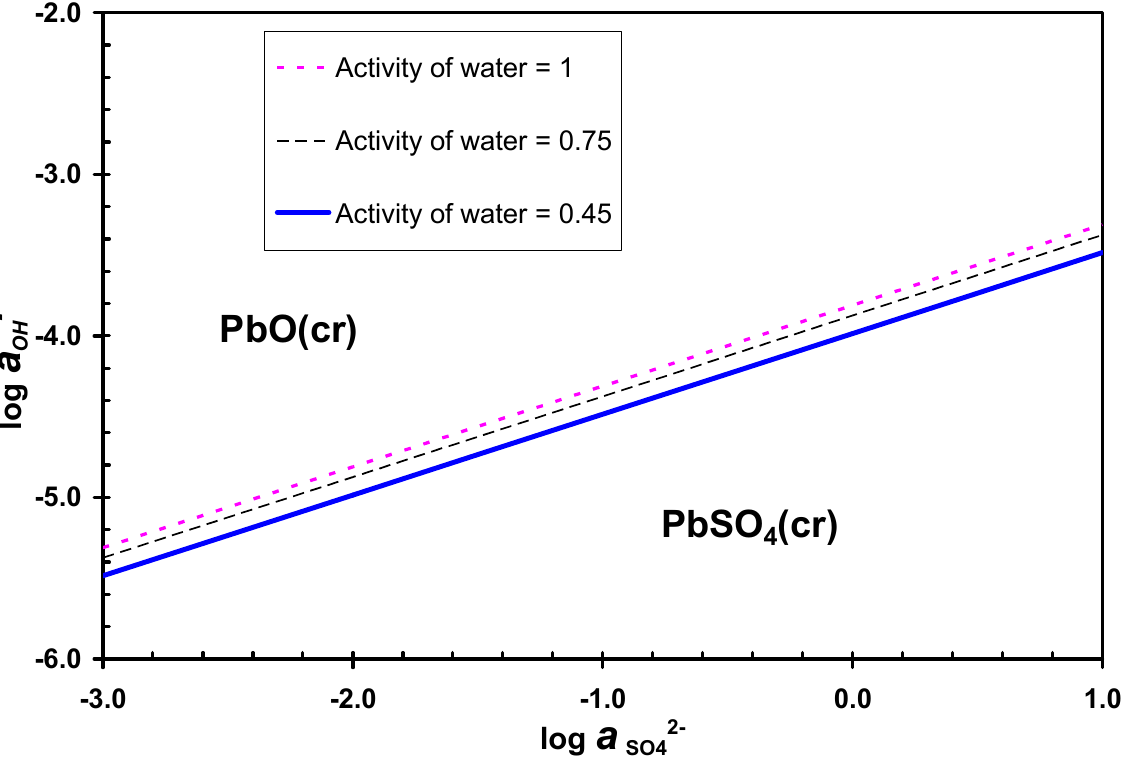
Figure 8. The stability fields of lead dioxide [PbO(cr)] and lead sulfate [PbSO 4 (cr)] at 25 °C in the space of log a versus log a in alkaline solutions for desulphurization of lead pastes at water activities of 1.0, 0.75, and 0.45, respectively.